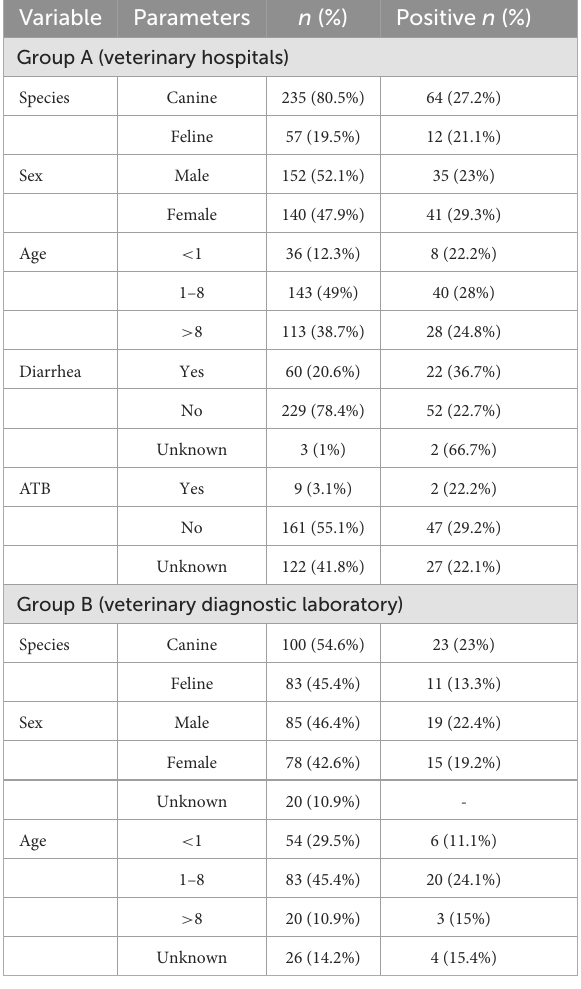
TABLE 1 Population characteristics and Clostridioides difficile positivity rate in groups A and B.